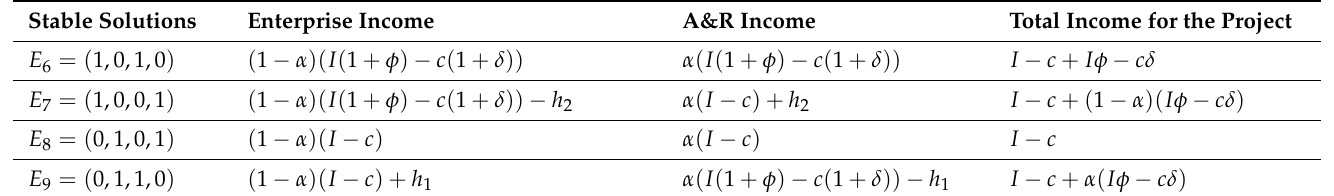
Table 2. Stable solutions E6 ∼ E9 and the corresponding benefits. Stable Solutions Enterprise Income A&R Income Total Income for the